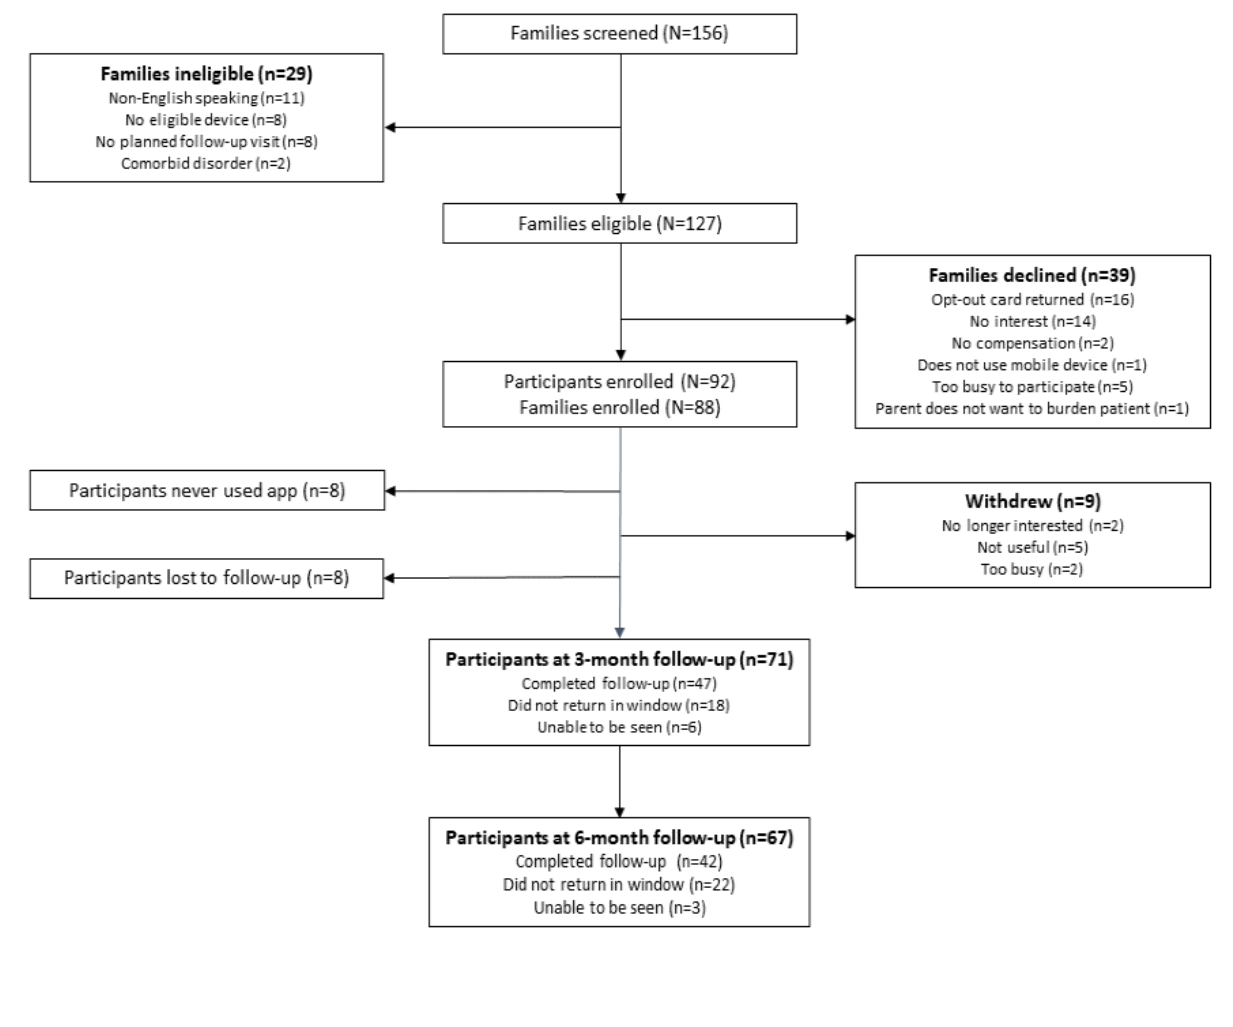
Figure 3. Participant flow diagram. Of the 127 eligible families, 88 were enrolled (92 participants). At 3 months, 77% (71/92) of participants remained in the study and 66% (47/71) completed the 3-month follow-up within the specified study time window. At 6 months, 74% (67/92) of the participants remained in the study and 63% (42/67) completed the 6-month follow-up within the specified study time